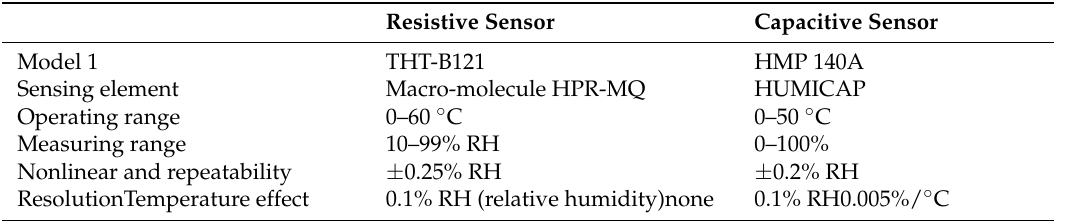
Table 2. The specifications of two humidity sensors.